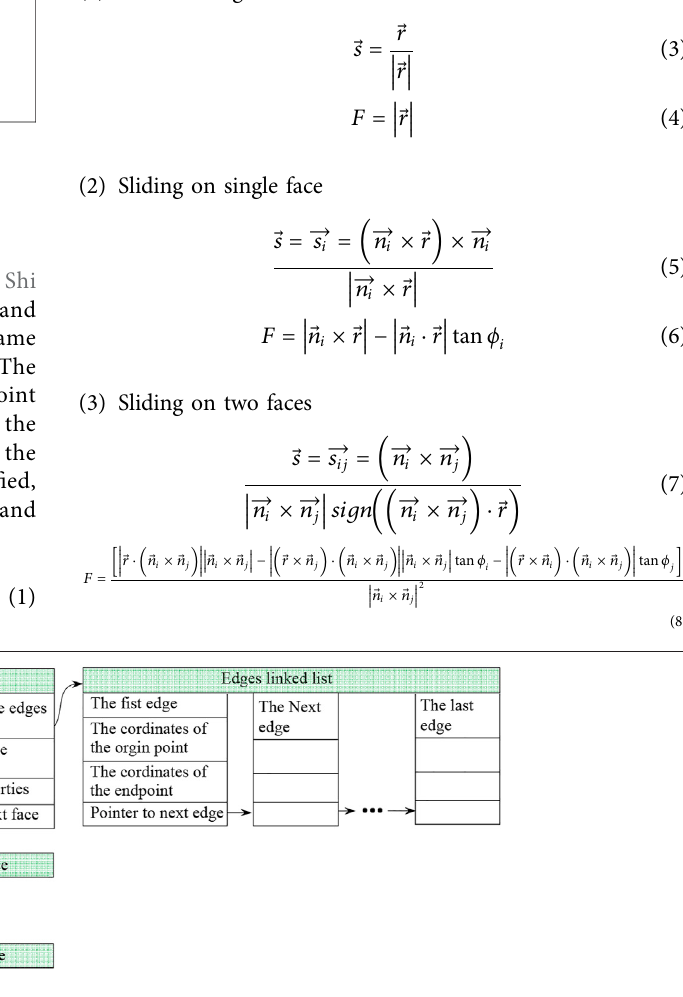
FIGURE 4 | Data structure of the